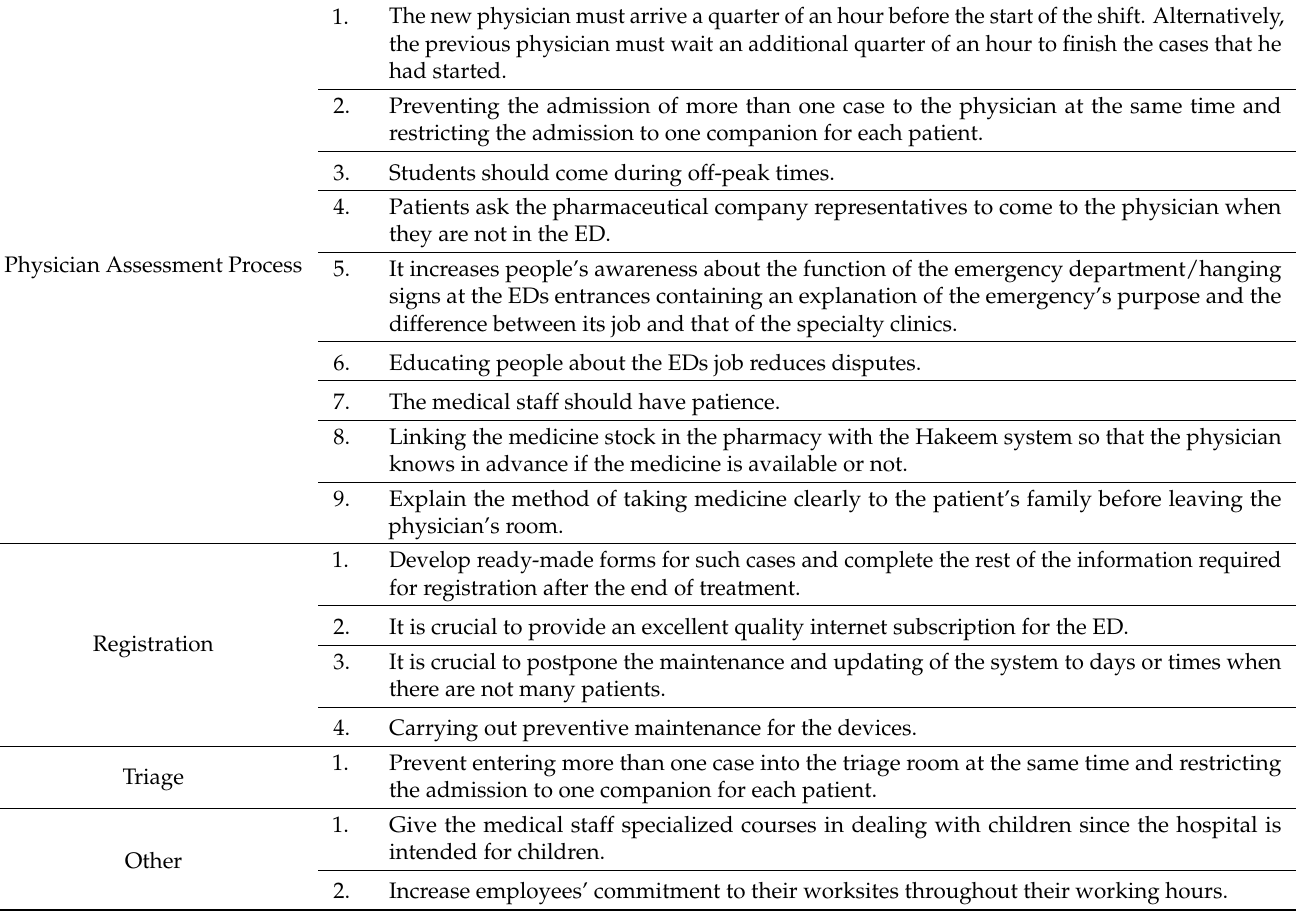
Table 11. Possible solutions to reduce the variability in the service and waiting time.